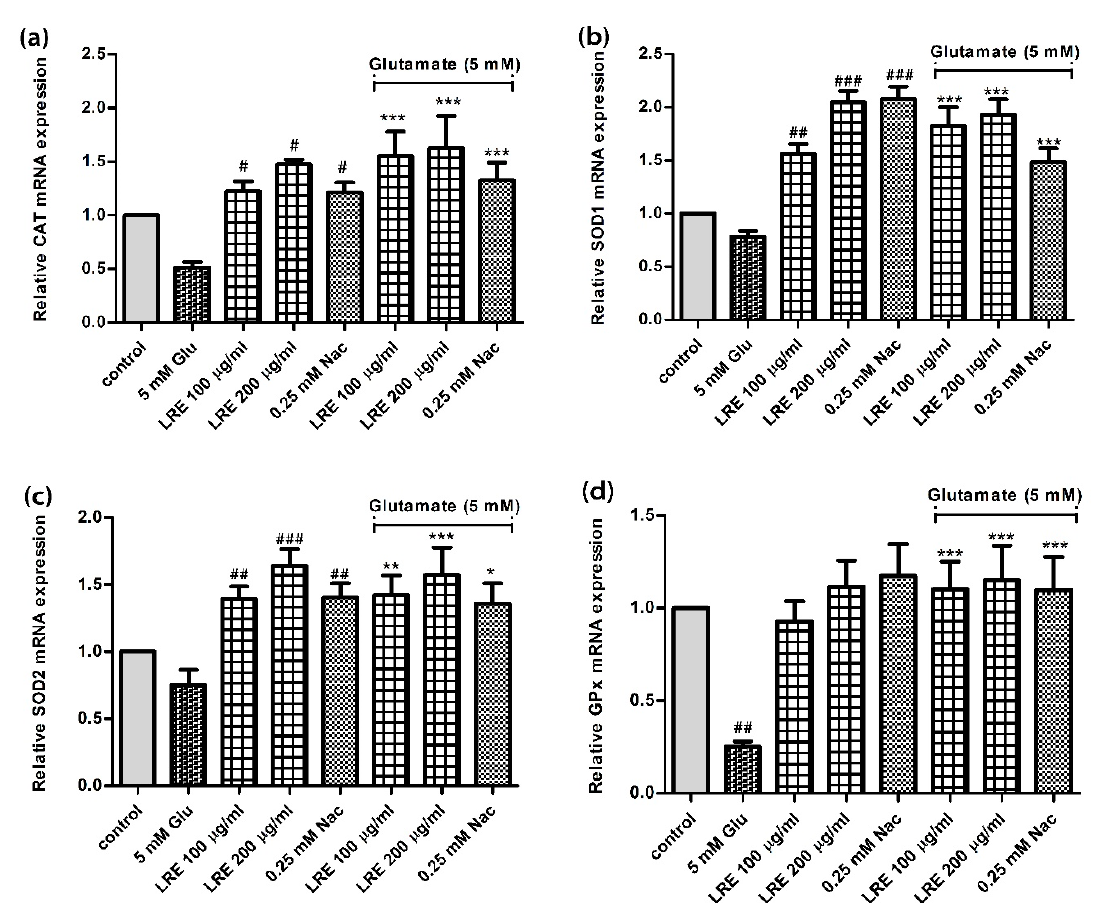
Figure 5. The effect of different concentrations of LRE extracts on the expression of antioxidant genes (catalase (CAT), superoxide dismutase (SOD1 and SOD2) and glutathione peroxidase (GPx)) in HT22 cells given alone or in combination with 5 mM glutamate. ( a ) CAT; ( b ) DOD1; ( c ) SOD2; ( d ) GPx. Values are mean ± SEM of at least three independent runs. # p < 0.05; ## p < 0.01; ### p < 0.001 vs. control; * p < 0.05; ** p < 0.01; *** p < 0.001 vs. glutamate alone.